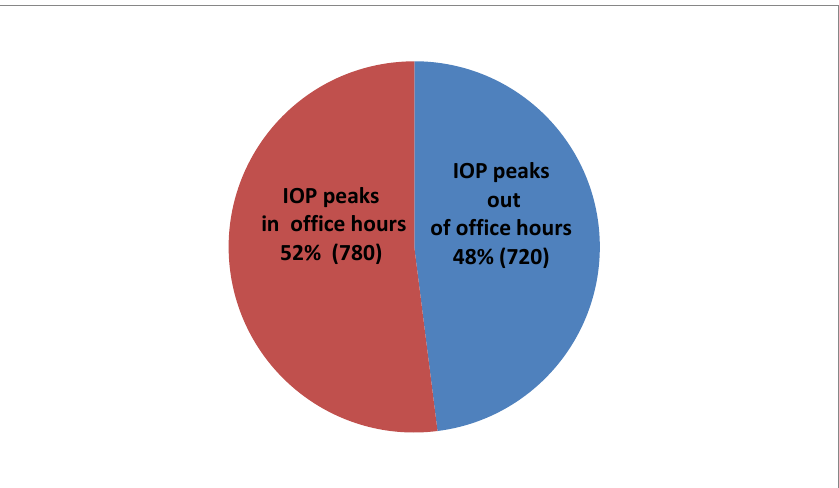
Figure 4. IOP peak percentages in conjunction with the office hours. A total of 250 patients (16.7% of total 1500, 28.4% of 879 patients on medication before IOP monitoring,) were in no need for antiglaucoma medical treatment change but, during their hospitalization, an adherence problem was revealed.